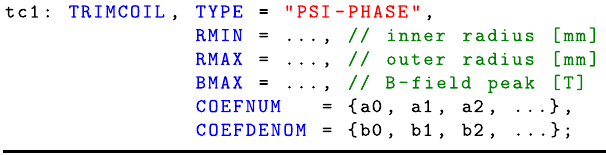
FIG. 12. OPAL input command for trim coils.